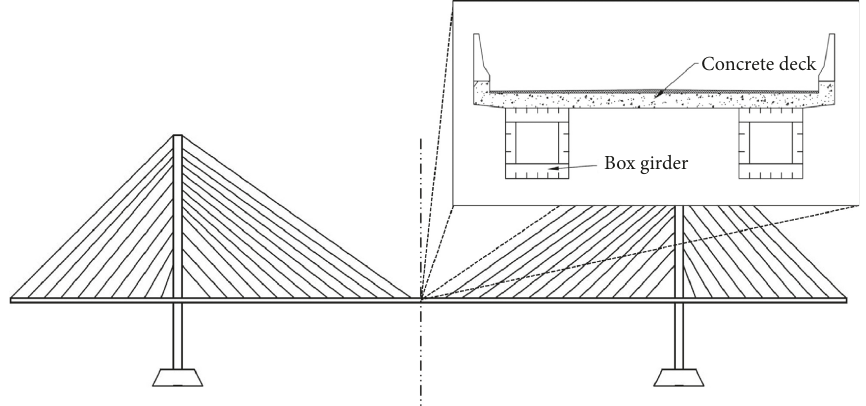
Figure 1: Typical shape of 2-edge box girder in cable-stayed bridge.